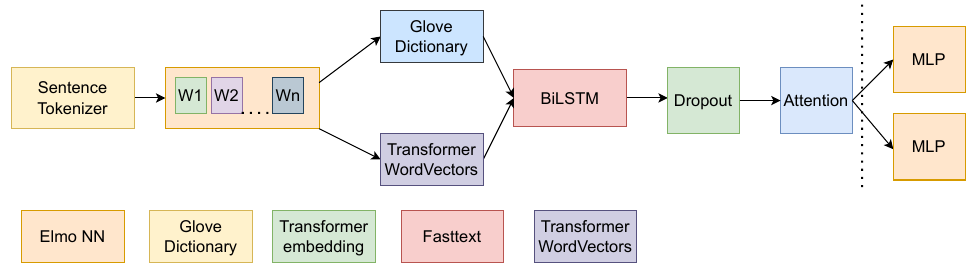
Figure 5. Transfer learning